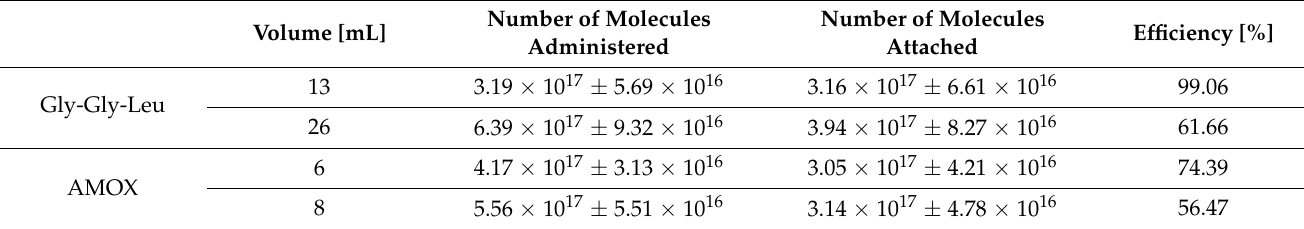
Table 1. Binding efficiency of the linker and AMOX (average values from four measurements calculated on 1 mg of GO).